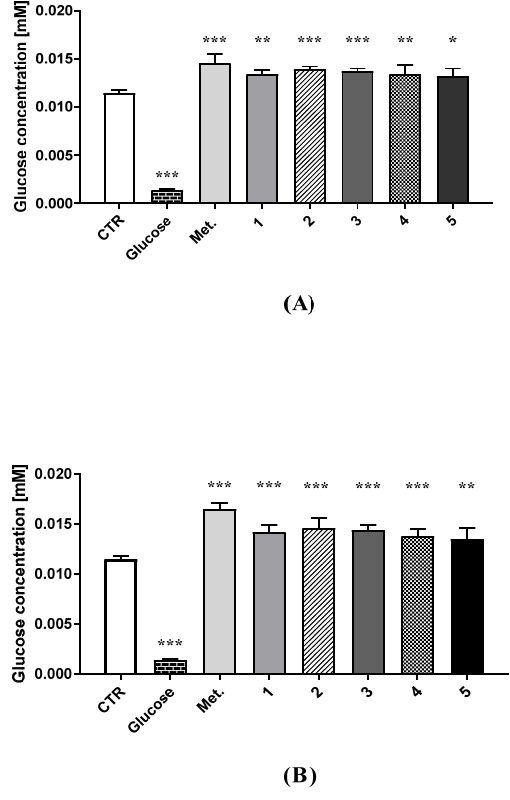
Figure 2. Effects of metformin and biguanide analogues 1 – 5 at the concentration of 0.1 ( A ) and 0.3 mM ( B ), and D-glucose at the concentration of 0.1 mM on the 2-NBDG uptake in HUVEC cells. The results are presented as mean ± SD, n = 4–6, and an asterisk denotes the significant differences between control and cells treated with glucose, metformin, or studied compounds. * p < 0.05; ** p < 0.01; *** p < 0.001.